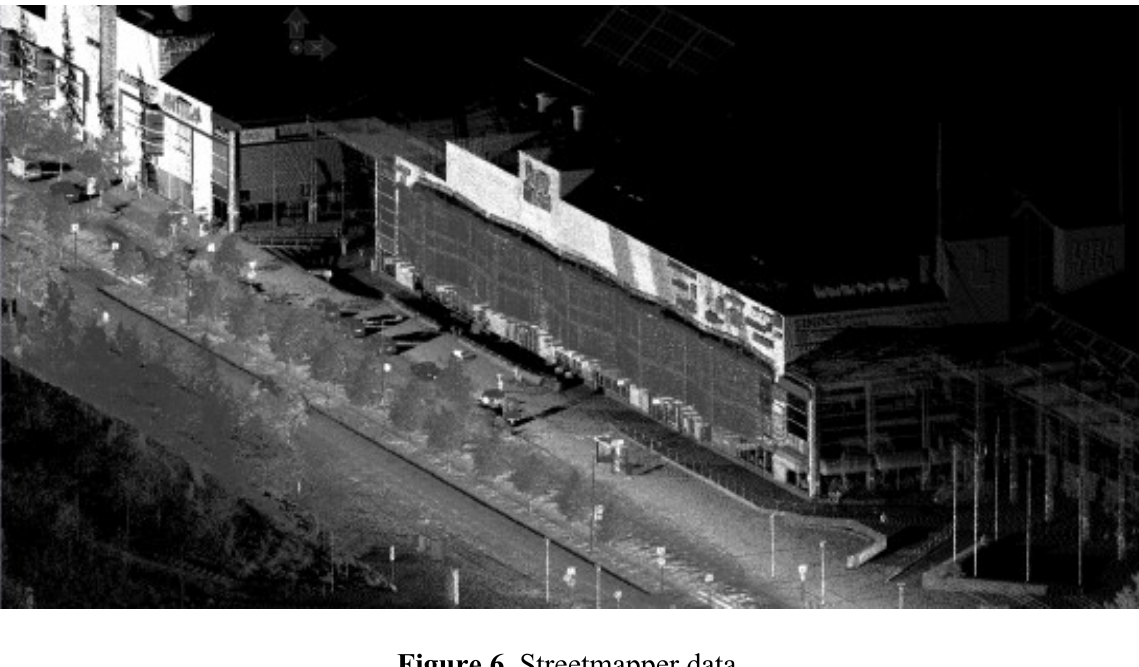
Figure 5. Optech Lynx data.